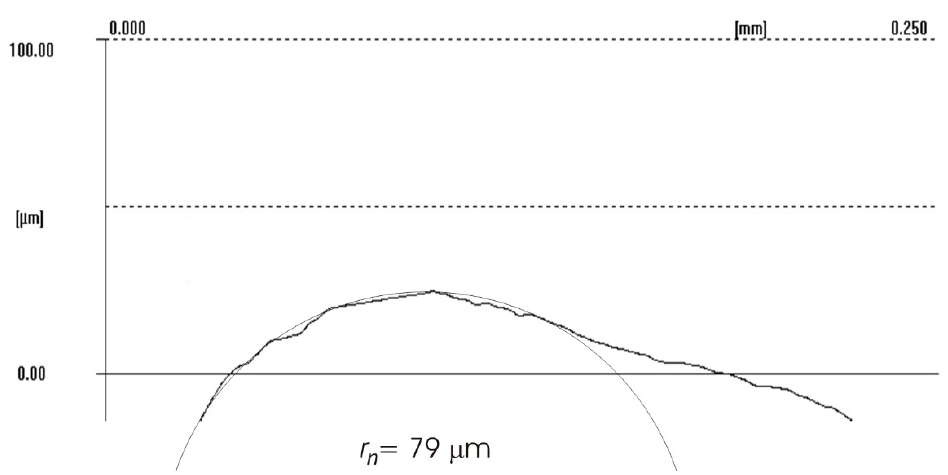
Figure 22. Cutting edge radius r n of the worn cutting insert after longitudinal turning with coolant (36 HRC).